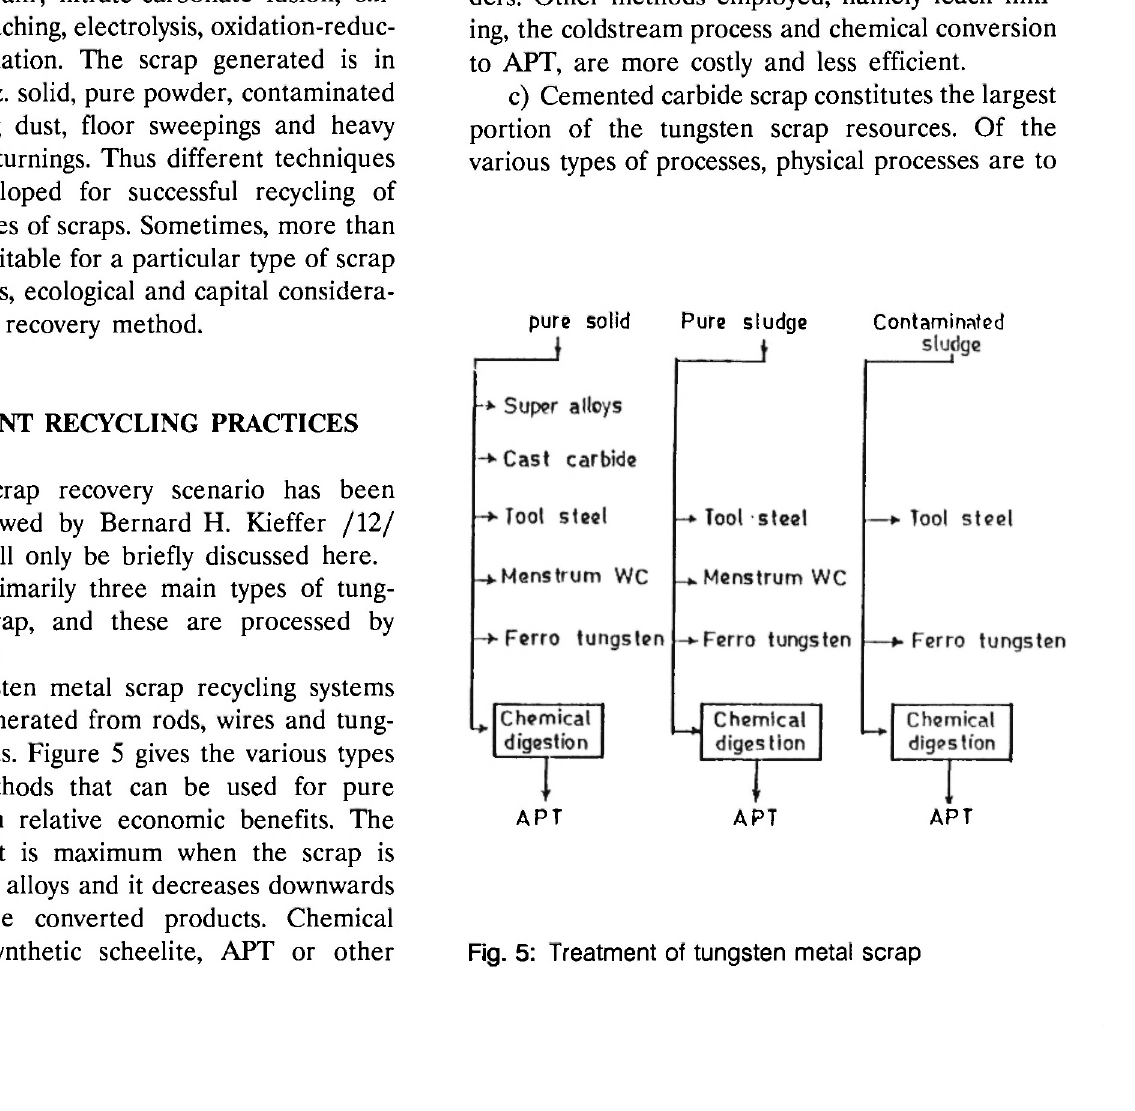
Fig. 5: Treatment of tungsten metal